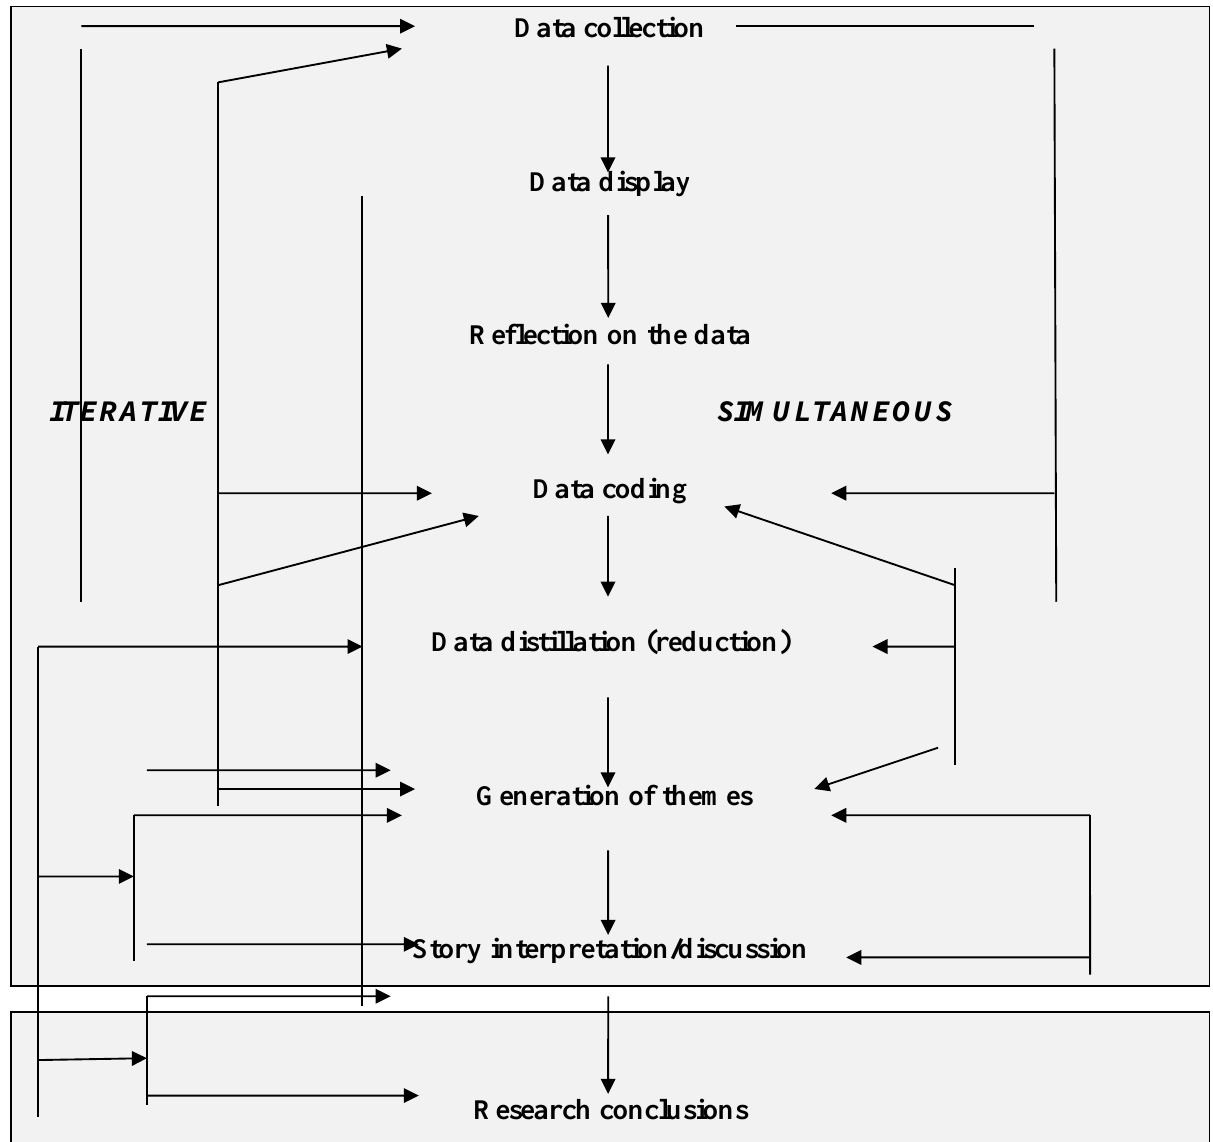
Figure 4.2: Tesch’s interactive process of data-analysis (Modified after Creswell,